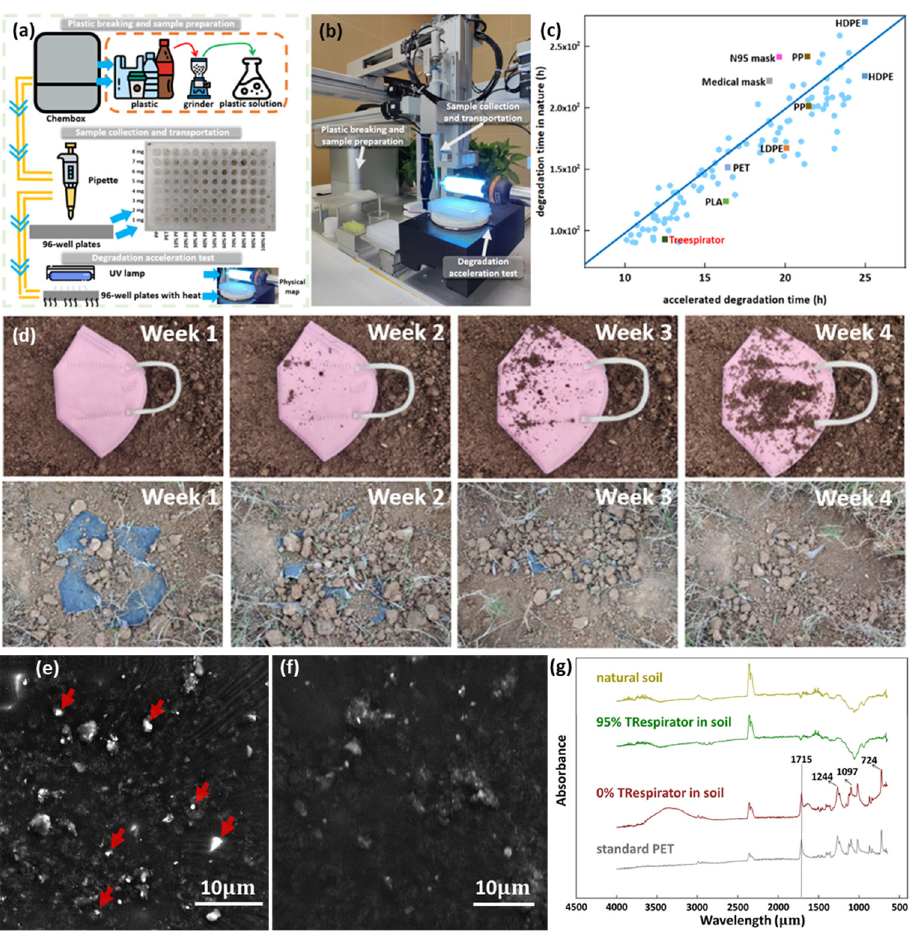
Figure 3. The degradation acceleration test and degradation performance re-check ( a ) the schematic diagram of the degradation acceleration test process. In the 96-well plate, the x -axis distributes 12 kinds of samples, which are PP sample, PET sample, plant-PET mixture samples from 10% plant fibers (PF) weight ratio to 100% weight ratio, and the y -axis is eight samples with different weights from 1 mg to 8 mg, ( b ) the physical map of the automatic degradation acceleration testing machine, ( c ) the image of the experimental data shown as light blue points, and the linear relationship between the degradation periods under acceleration and in nature, ( d ) the degradation process of a N95 mask and TRespirator from week 1 to week 4, ( e , f ) the SEM images of the soil in which the degradation test of the membrane without plant fibers and plant fiber membrane takes place, respectively, where the highlights are micro and nano plastics in different size ( g ) the FTIR test of standard PET material, the soil after the degradation of the plastic membrane, the soil after TRespirator degradation, and natural soil sample; 95% TRespirator means a TRespirator sample with fibers 95 weight percent, and 0% TRespirator means a TRespirator with no fibers.